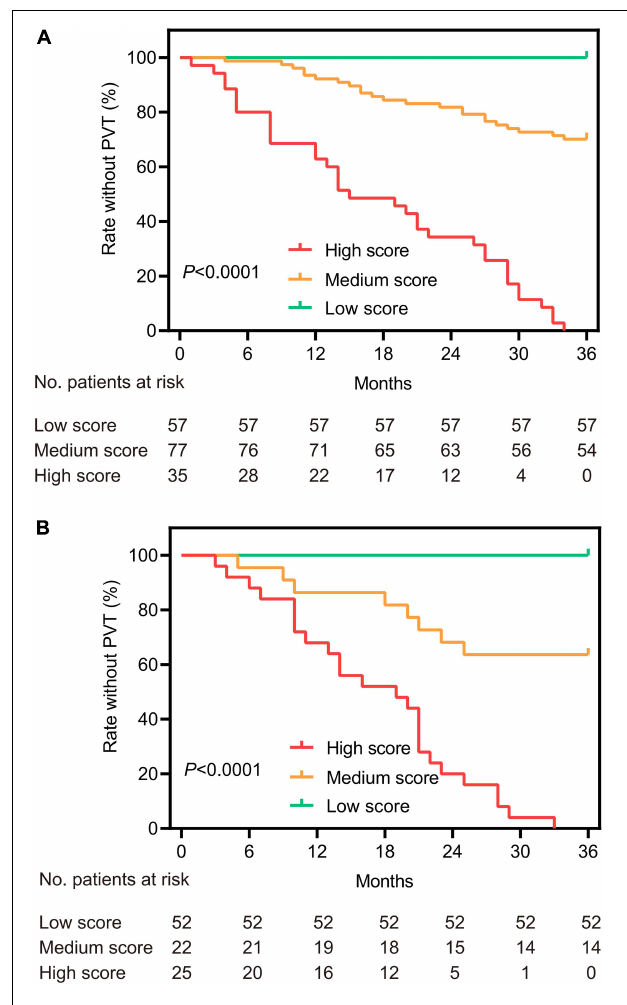
FIGURE 3 | Kaplan–Meier survival curves based on the total points of the nomogram for the training (A) and validation (B) cohorts. According to the cutoff values of the nomogram, patients were divided into three categories and plotted the survival curves for the rate without